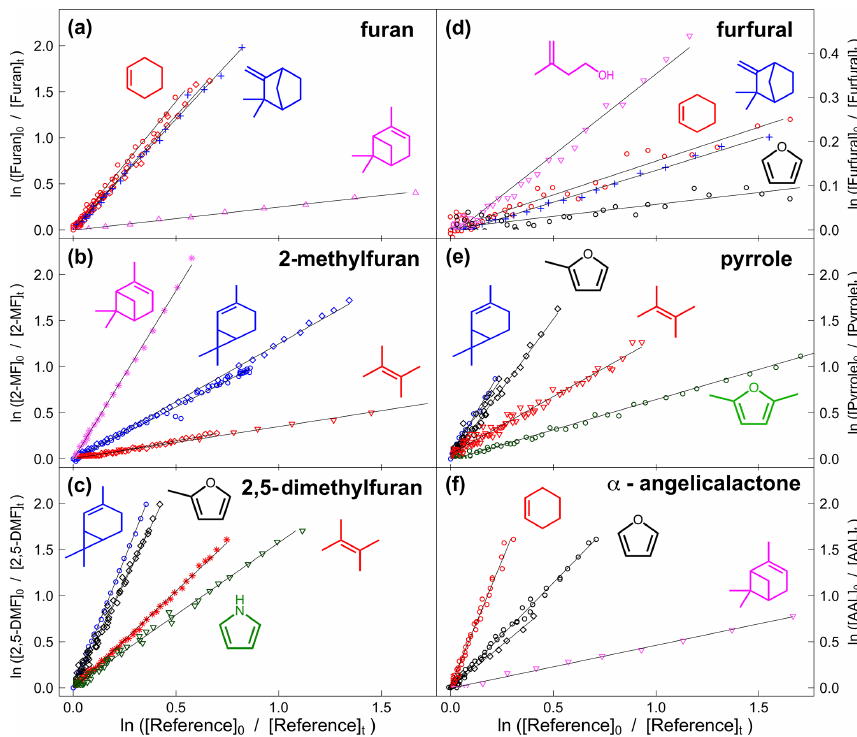
Figure 2. Relative rate plots for (a) furan relative to cyclohexene (red), camphene (blue), and α -pinene (pink); (b) 2-methylfuran relative to 2-carene (blue), 2,3-dimethyl-2-butene (red), and α -pinene (pink); (c) 2,5-dimethylfuran relative to 2-carene (blue), 2,3-dimethyl-2-butene (red), 2-methylfuran (black), and pyrrole (green); (d) furfural relative to camphene (blue), cyclohexene (red), furan (black), and 3-methyl-3- buten-1-ol (pink); (e) pyrrole relative to 2-carene (blue), 2,3-dimethyl-2-butene (red), 2-methylfuran (black), and 2,5-dimethylfuran (green); and (f) α -angelicalactone relative to cyclohexene (red), furan (black), and α -pinene (pink). Different shapes are used for different experiments with the same reference